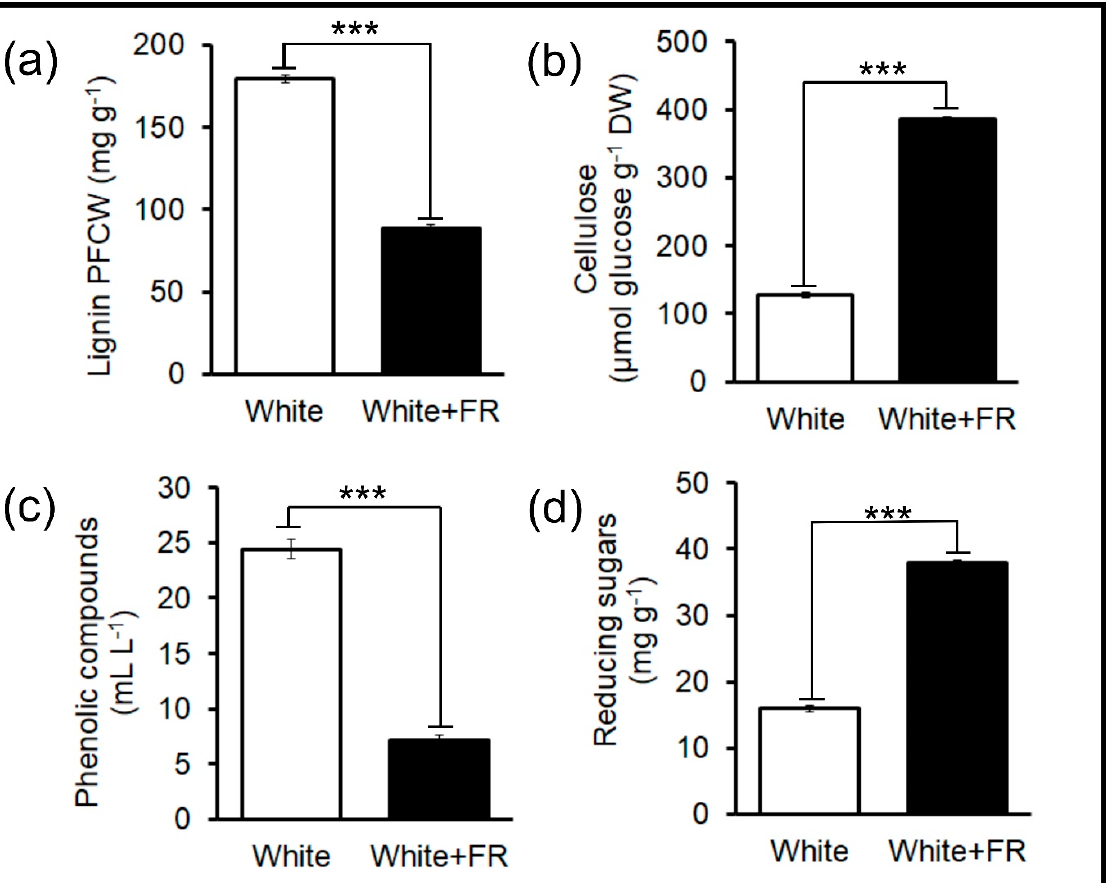
Figure 4. Metabolic compounds extracted from the cell wall of tobacco stems. ( a ) Lignin content in protein ‐ free cell walls (PFCWs). ( b ) Cellulose content is equivalent to the glucose standard. ( c ) Total phenolic compounds equivalent to gallic acid. ( d ) Reducing sugars extracted from the cell wall. Asterisks (***) indicate statistical differences between treatments using the Student’s t ‐ test ( p <0.001); (n = 10 ± SE).